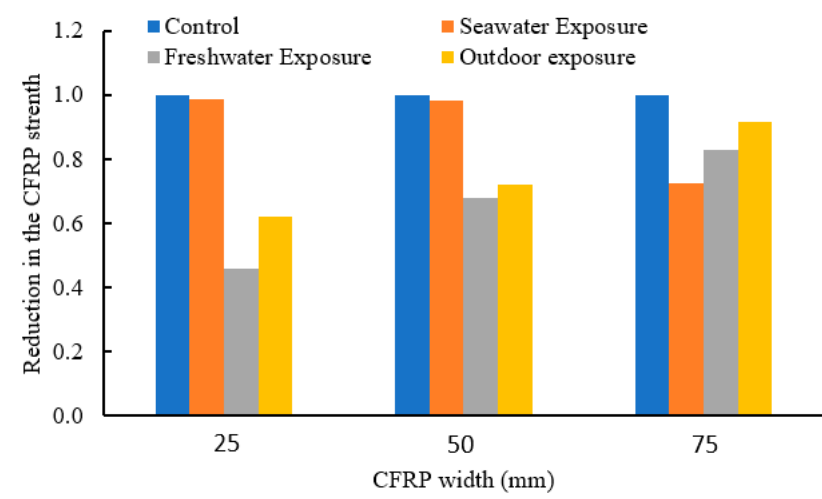
Figure 11. Effect of 195 days of exposure on CFRP